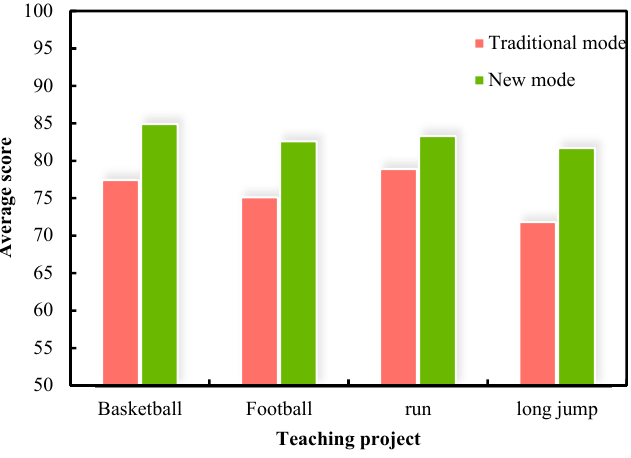
Figure 4. Average Scores of Four Sports under Two Models.